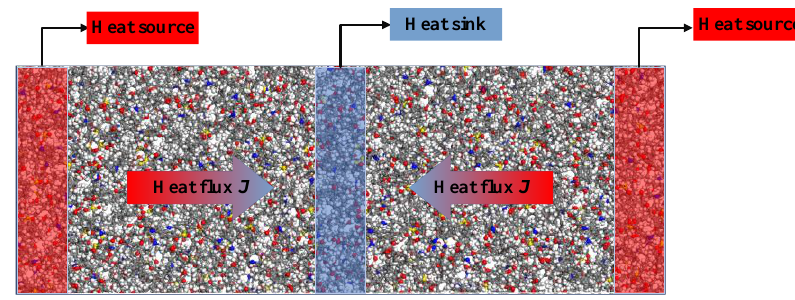
Table 1. T g (units: K) of models.